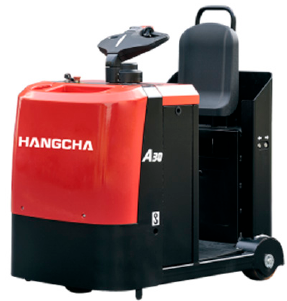
Figure 1. Electric forklift.